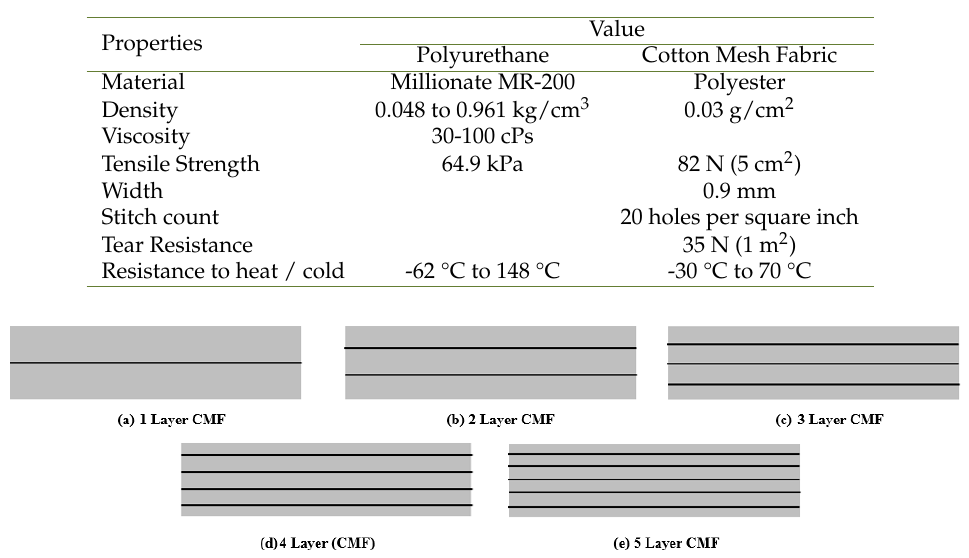
Table 1. Specifications of Material Core